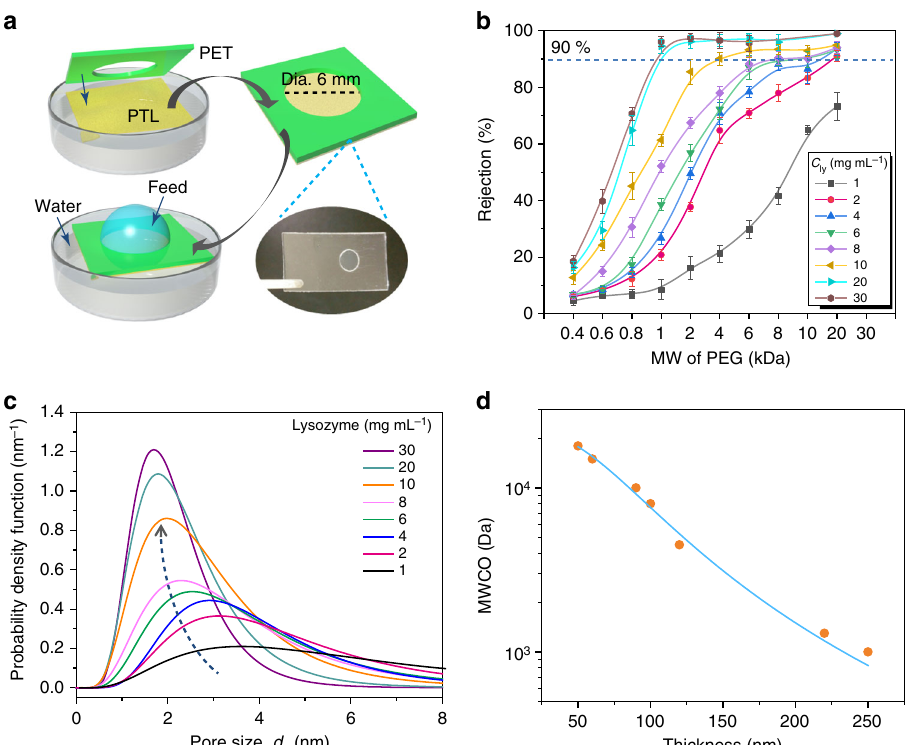
Fig. 2 The pore size of the cross-linked PTL membranes and rejection of neutral linear PEG. a Schematic of the permeation of PEG dissolved in water. The membrane was transferred to a PET substrate with a 6 mm dia. pore size for the permeation tests. b Rejection of PEGs of different molecular weight by membranes of different thickness (as controlled by the lysozyme concentration during the membrane preparation). Three repeated tests were performed for each set of measurements and error bars represent standard deviation. c Probability density function curve showing the pore size distribution of the cross-linked PTL membrane. The lines represent the fi tting to the solutions of the simultaneous differential equations in Equation (2). d The molecular weight cut-off (MWCO) of the membranes with different